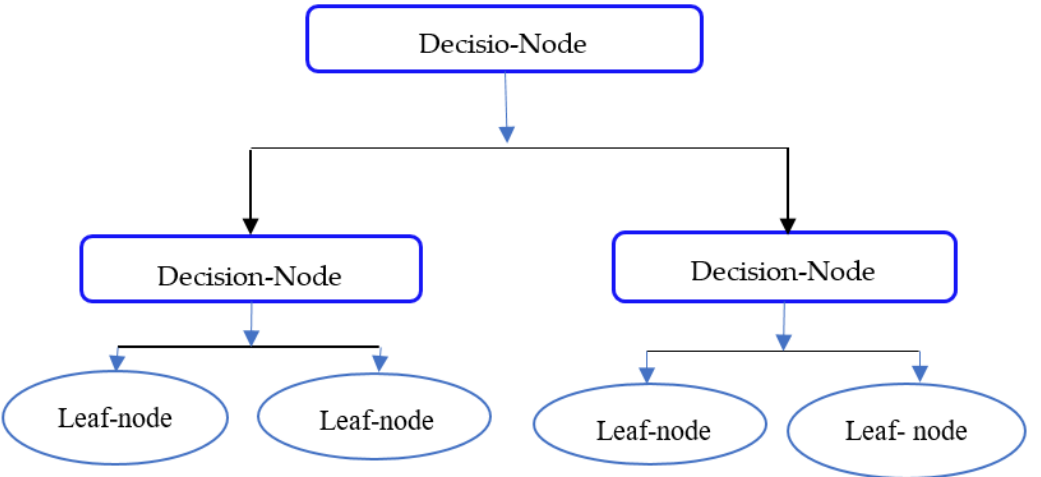
Figure 3. Decision Figure 3. Decision trees.